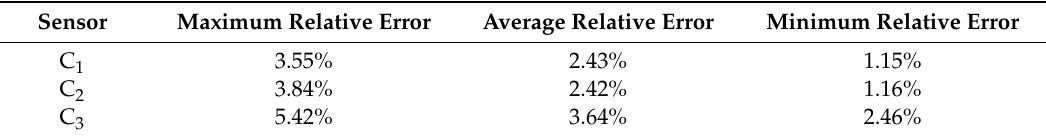
Table 3. Comparison between simulated results and experimental results.